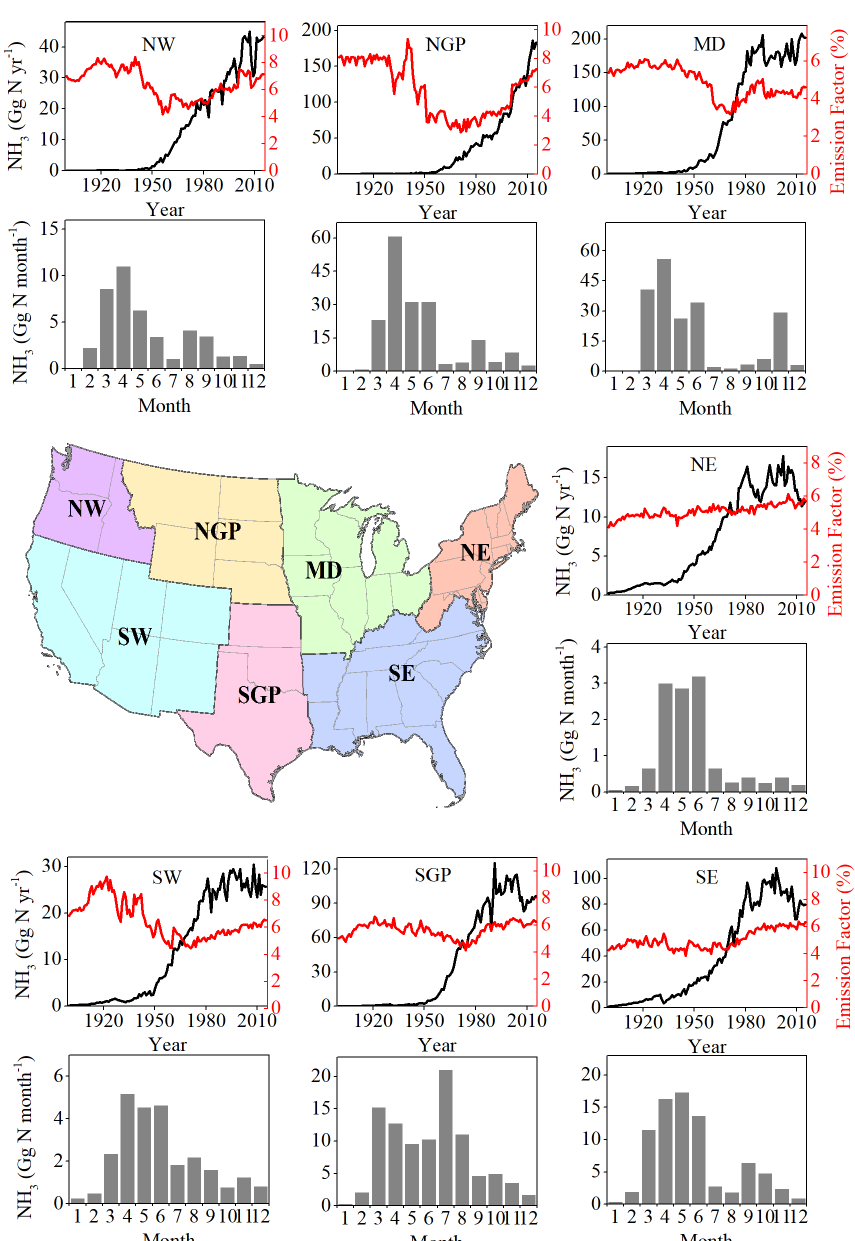
Figure 2. Temporal and monthly pattern of NH 3 emissions in seven regions of the United States. The seven regions include the North- west (NW), the Northern Great Plains (NGP), the Midwest (MD), the Northeast (NE), the Southwest (SW), the Southern Great Plains (SGP), and the Southeast (SE). Annual NH 3 emission is shown by black lines. Red lines represent the proportion of NH 3 emission to N fertilizer input. Grey bars indicate monthly NH 3 emissions of each region in